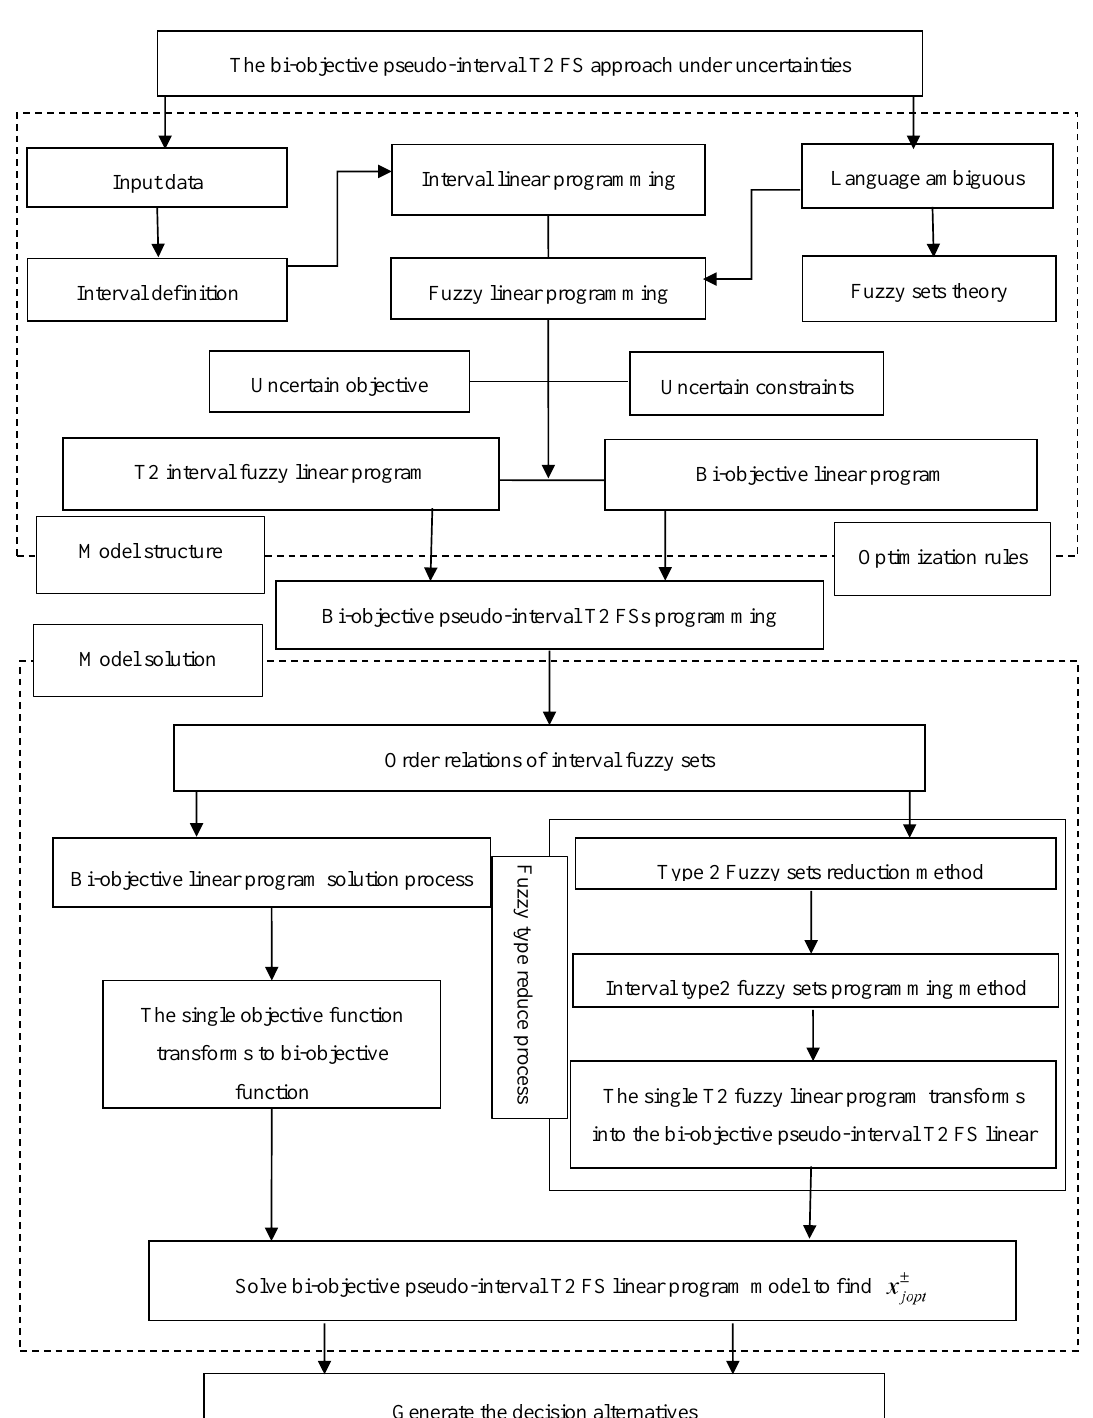
Figure 2. Flow chart of developed approach model.